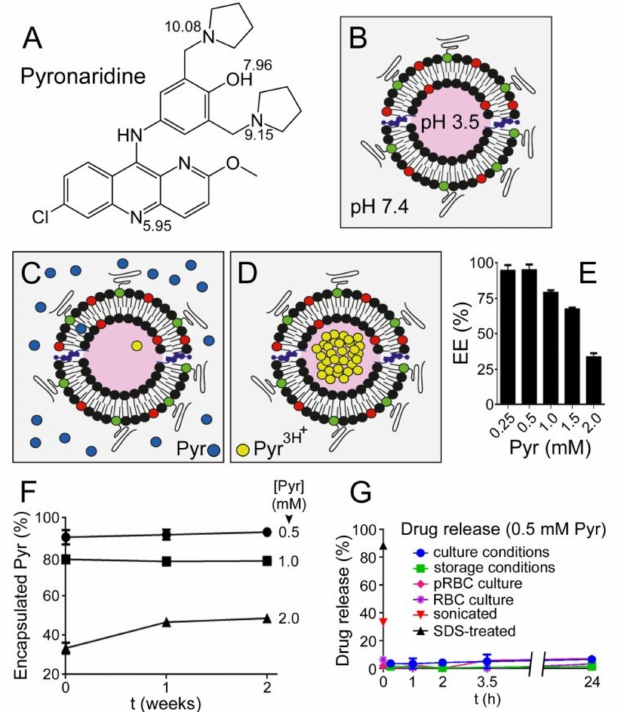
Figure 2. Pyronaridine encapsulation. ( A ) Pyronaridine structure with the pKas of relevant protonable groupsindicated. ( B )Schemeofthetransmembrane7.4 → 3.5pHgradient. ( C , D )Schemeofpyronaridine (Pyr) encapsulation. ( E ) Pyronaridine encapsulation e ffi ciency (EE) in LPs (5 mM lipid) at di ff erent initial drug concentrations. ( F ) Stability of pyronaridine encapsulation at 4 ◦ C. ( G ) Pyronaridine release assay from LPs (molar ratio lipid:pyronaridine ca. 10:1) incubated under di ff erent conditions (see text for